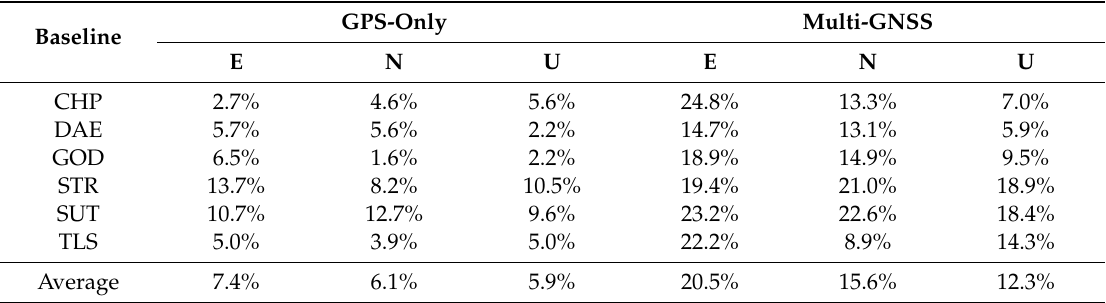
Table 6. Accuracy improvement percentages of HVCE GPS-only and HVCE Multi-GNSS strategies compared with the corresponding ED methods from DoY 171 to 200 in 2019.